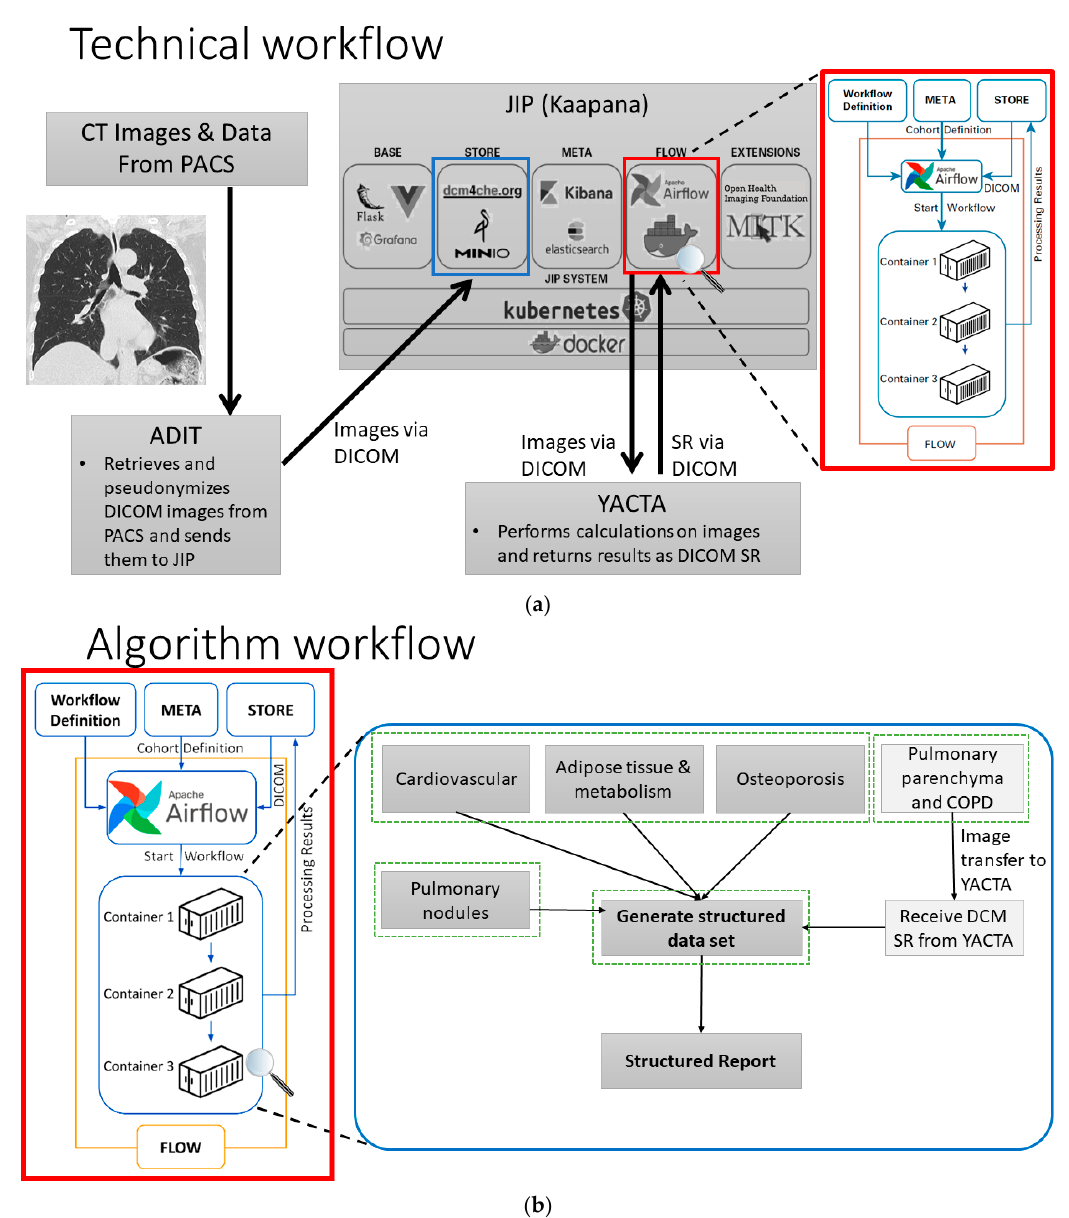
Figure 1. Flowchart of planned software integrations with: ( a ) Technical workflow and ( b ) Algorithm